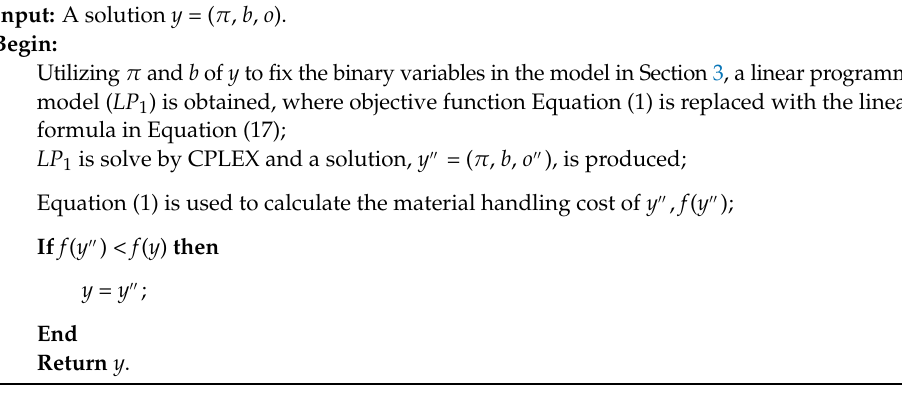
Algorithm 4. Optimize the exact location of each machine by exact